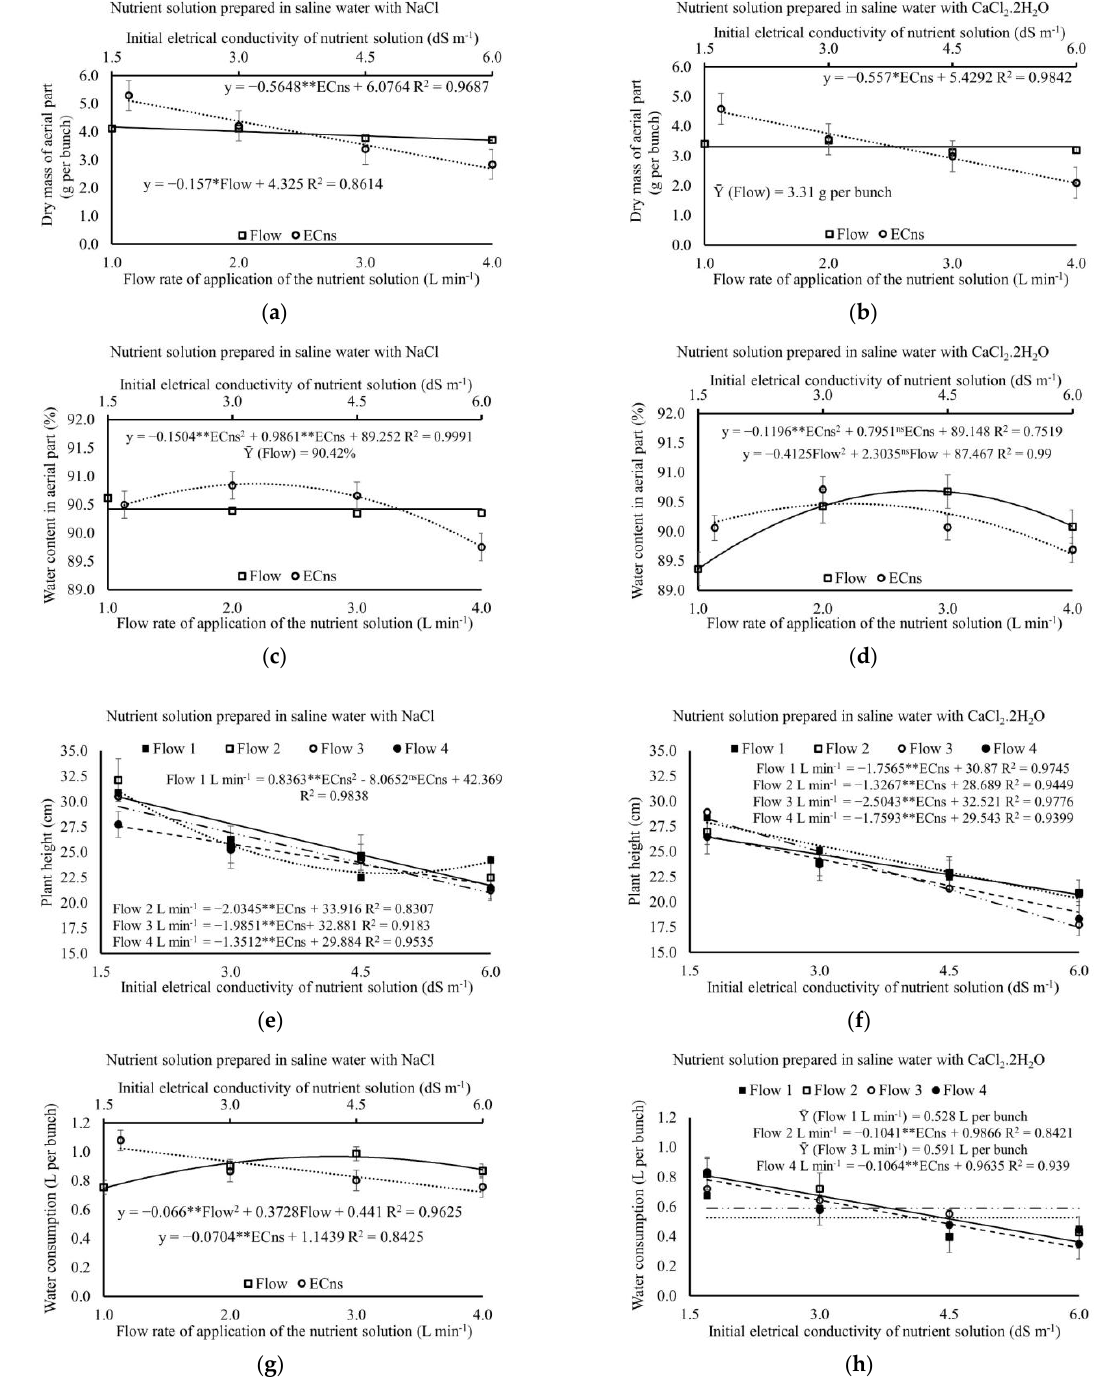
Figure 6. Dry mass ( a , b ) and water content of aerial part ( c , d ), average height of bunches ( e , f ), and total water consumption ( g , h ) of coriander plants, cv. Verdão, exposed to nutrient solutions pre-